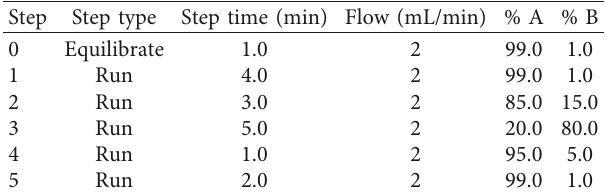
Table 1: HPLC flow programme used for antibiotic residue